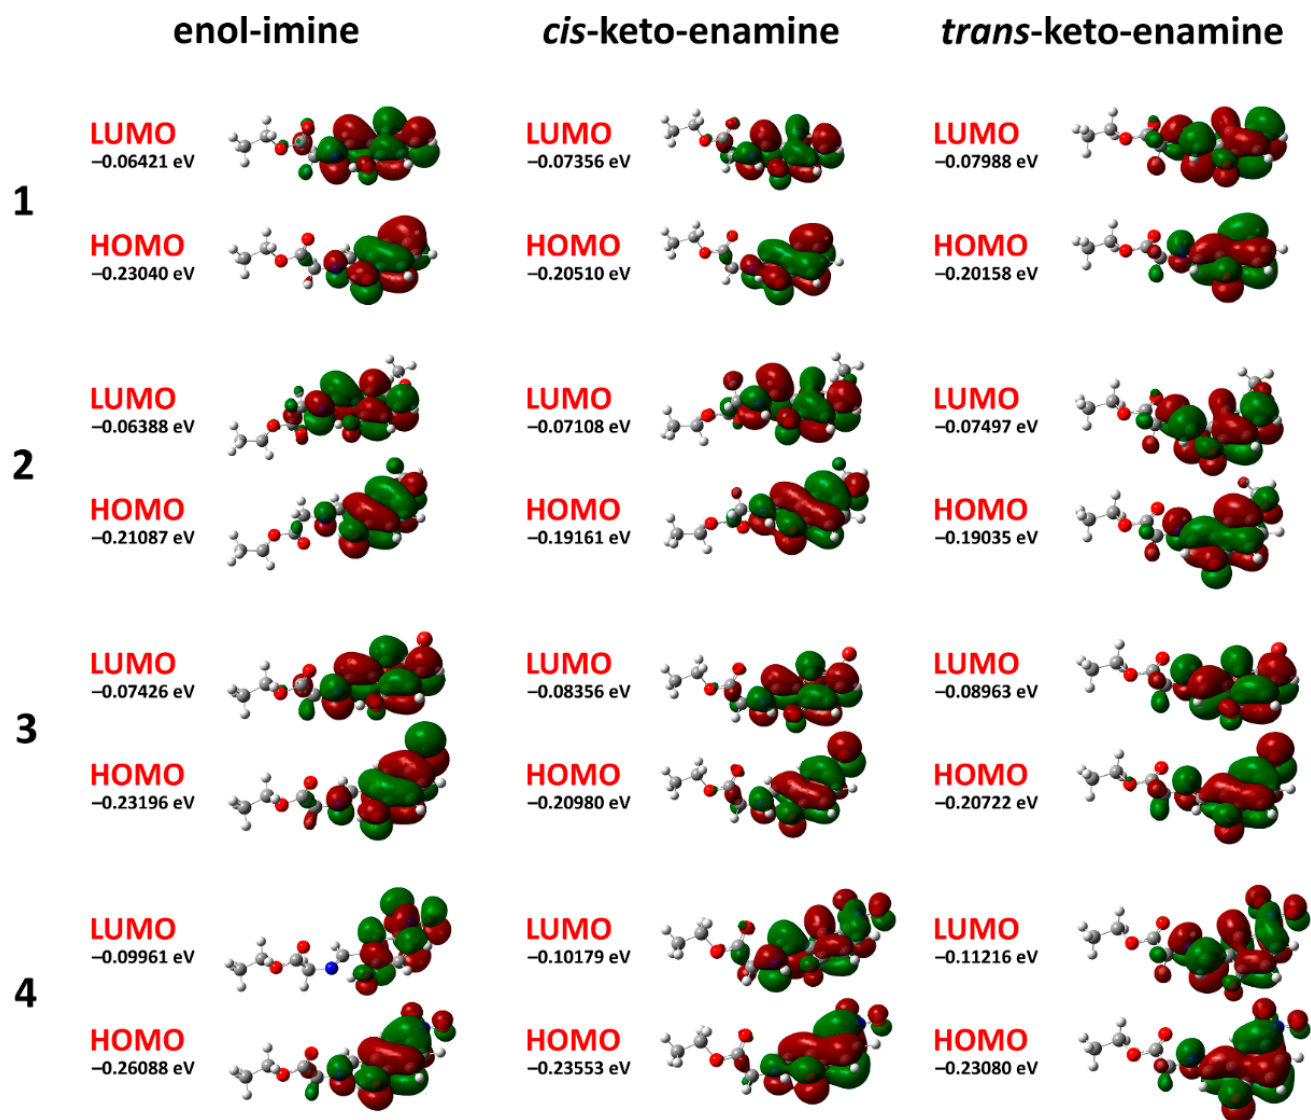
Figure 9. Energy levels and front views on the electronic isosurfaces of the high occupied and low unoccupied molecular orbitals of the ground state of 1–4 , obtained by using the B3LYP/6-311++G(d,p) method.